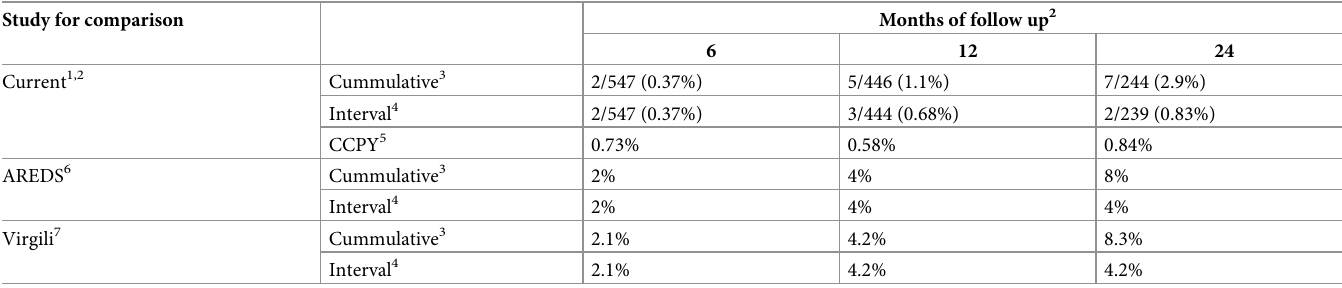
Table 6. Incidence of new CNV in dry AMD at various time points 1